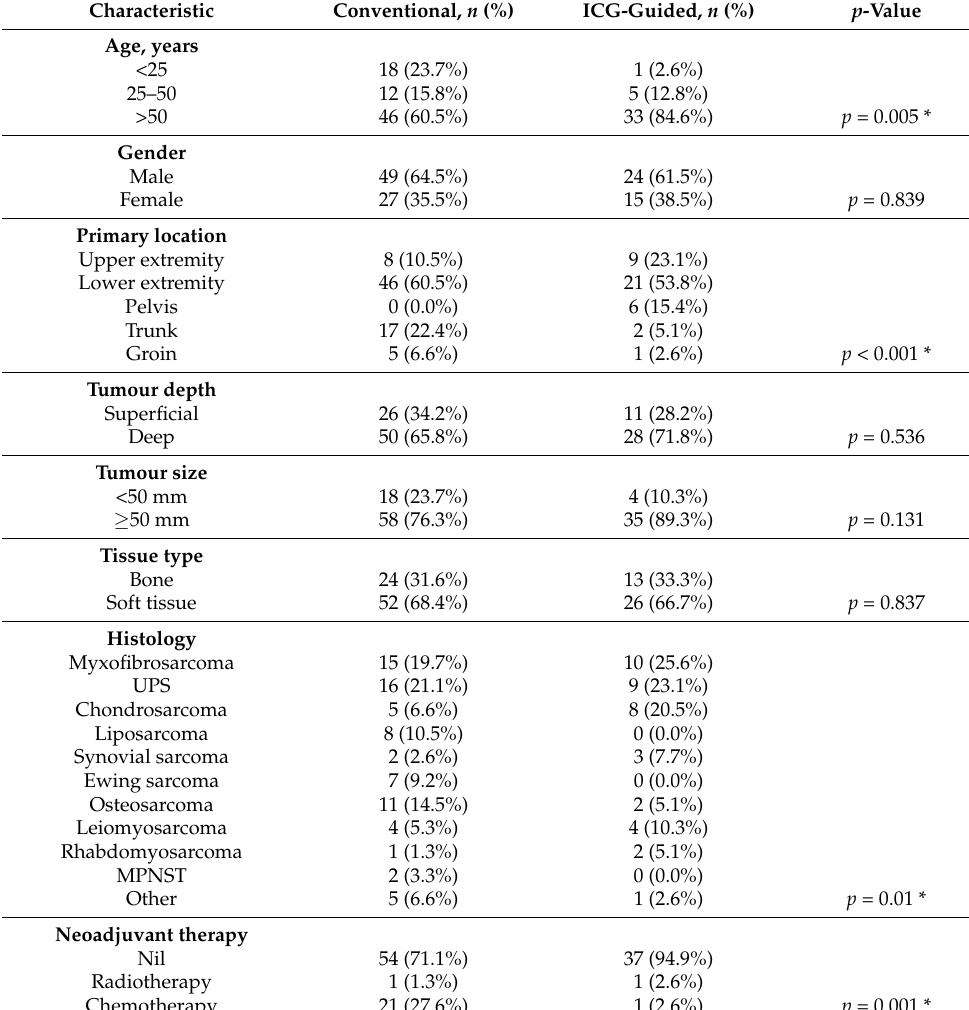
Table 1. Patient demographics and clinical